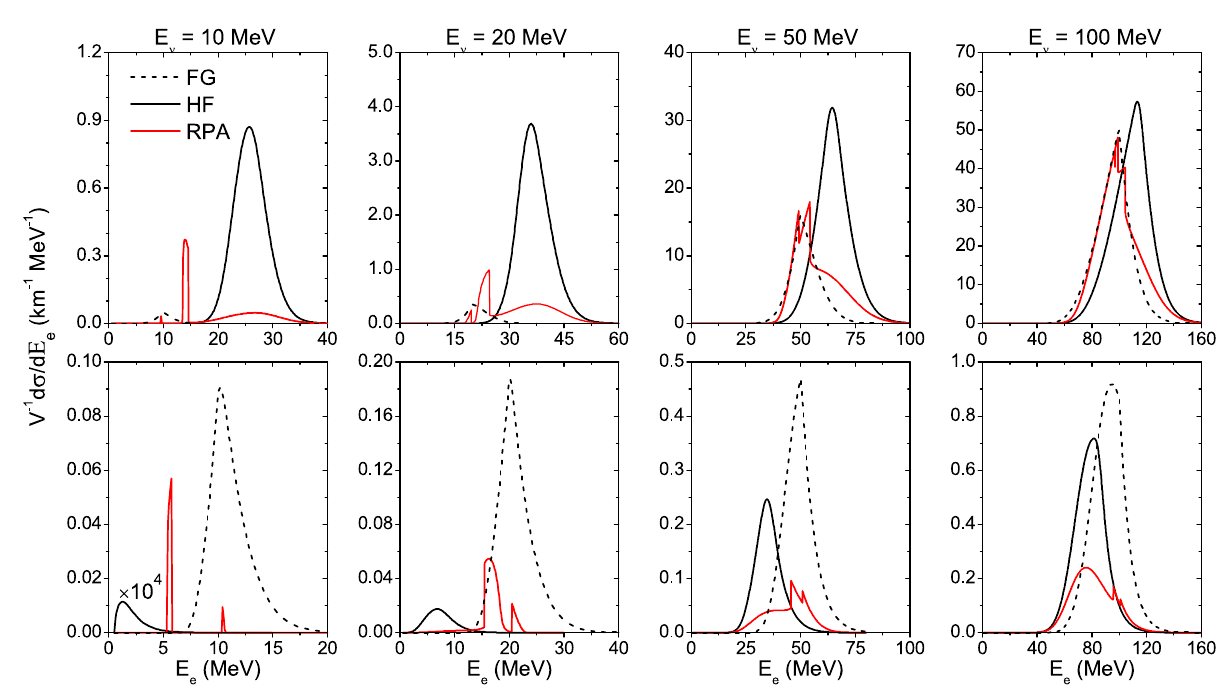
Figure 3. (Color online) Di ff erential cross sections for neutrino (upper panels) and antineutrino (lower panels) absorption, evaluated at beta-equilibrium conditions ρ = 0 . 02fm − 3 , T = 8MeV, and Y p = 0 . 029. The Skyrme force LNS is used in the HF and RPA Figure 2. (Color online) Finite temperature ( T = 8 MeV) strength calculations. In each panel the dashed line shows the noninteracting Fermi gas cross sections. For antineutrinos with E ¯ ν functions calculated with the LNS Skyrme potential at three val- the HF cross section is scaled by the factor 10 4 . ues of momentum transfer. The density and the proton fraction are the same as in Fig. 1